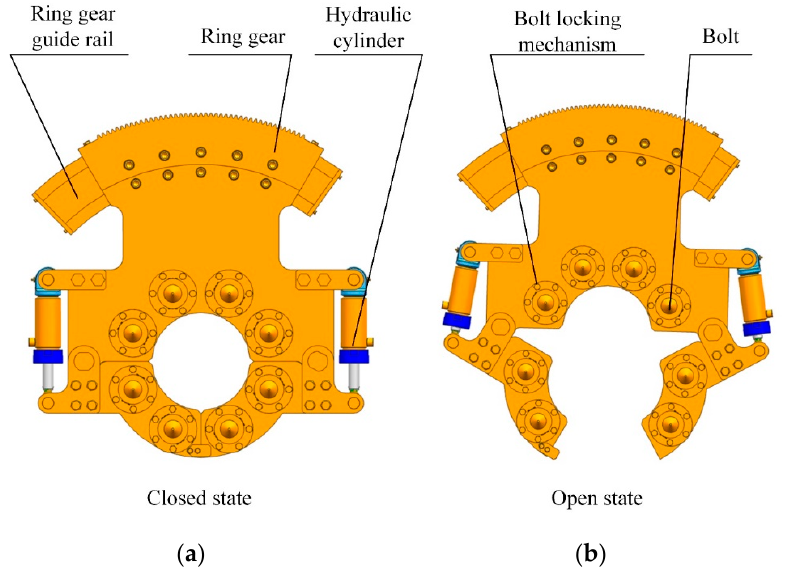
Figure 2. The structure of bolt magazine in the closed state ( a ) and open state ( b ). The coordinate system of the deep-water bolt flange automatic connection tool is cre- ated using the D–H method, as shown in Figure 4. The initial coordinate system O 0 — X 0 Y 0 Z 0 is established on the frame, the coordinate system of the bolt magazine is O i — X i Y i Z i ( i = 1~5), and that of nut magazine is O i’ — X i’ Y i’ Z i’ ( i = 1~5).